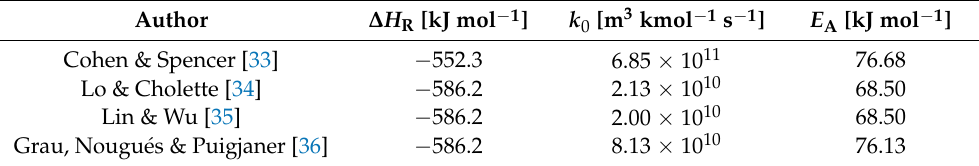
Table 1. Thermokinetic parameter of the oxidation of NaTS with HP, determined by calorimetric investigations under the assumption of a constant pH value during the reaction.